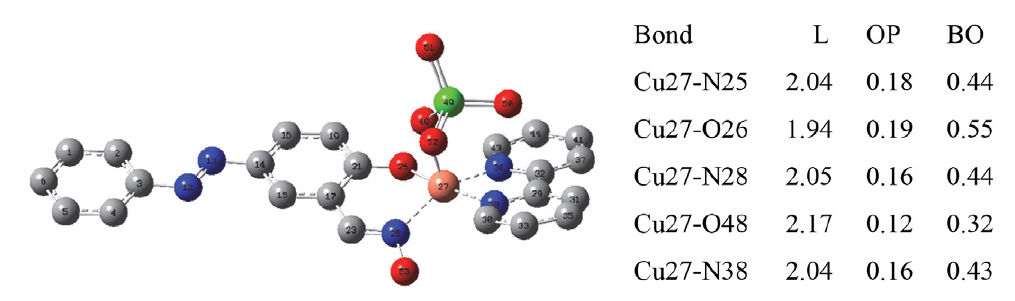
Figure 6: Optimized molecular structure of the complex 4 and selected bond length in Å (L), overlap population (OP) and bond order (BO).